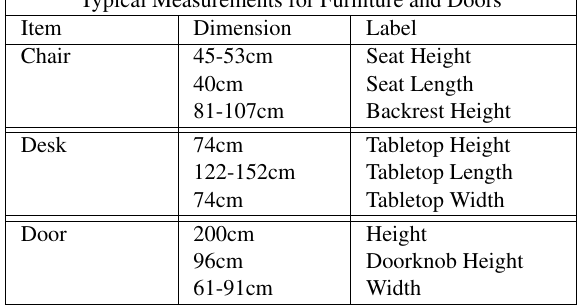
Table 1: Table showing the average dimensions of furniture and